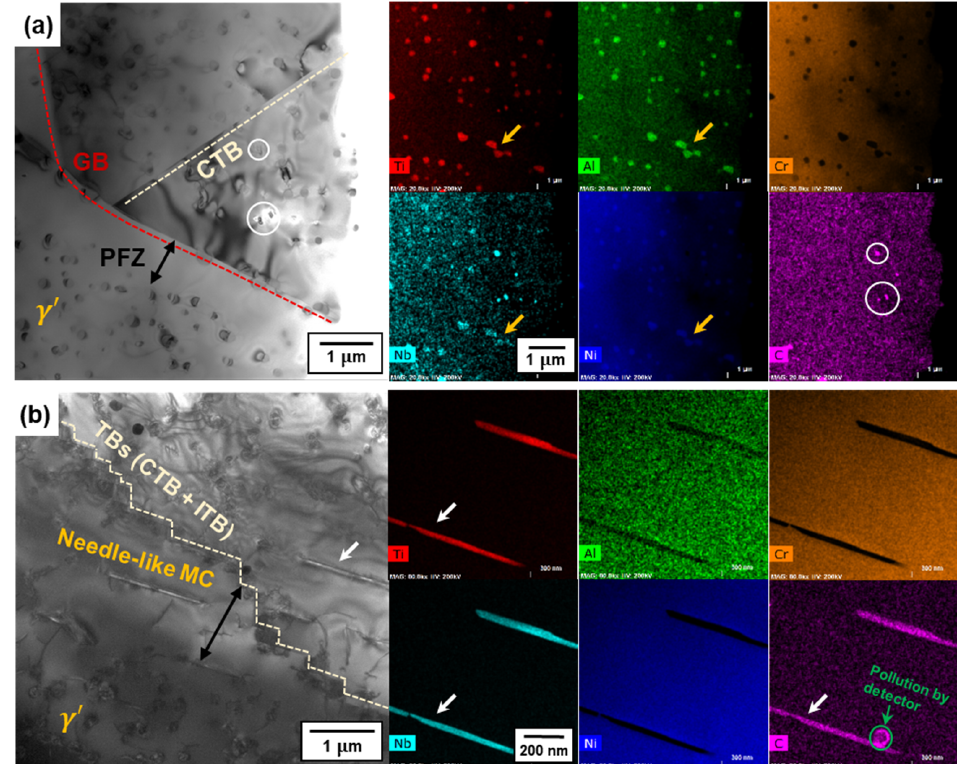
Figure 3. TEM-EDS images of ( a ) FG-A and ( b ) CG-A specimens. The white circles and yellow arrows in ( a ) indicate primary carbides and coarse gamma-prime precipitates at grain boundaries and the neighboring region, respectively. The white arrows in ( b ) indicate needle-like MC carbide around incoherent twin boundary.